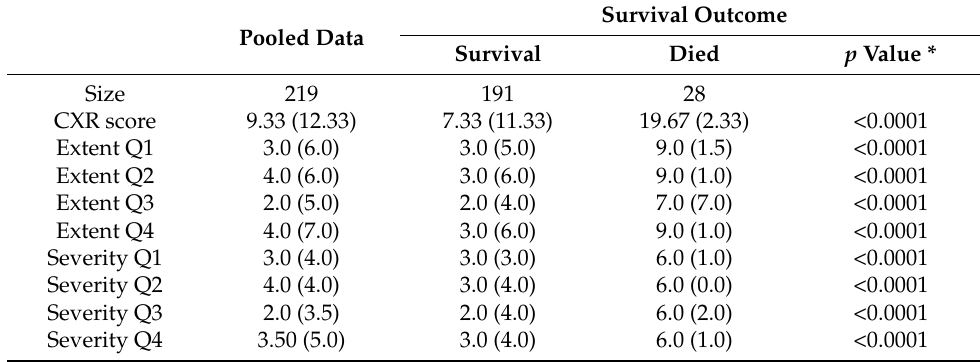
Table 2. Chest radiograph scores on the first 24 h from admission among surviving and dead